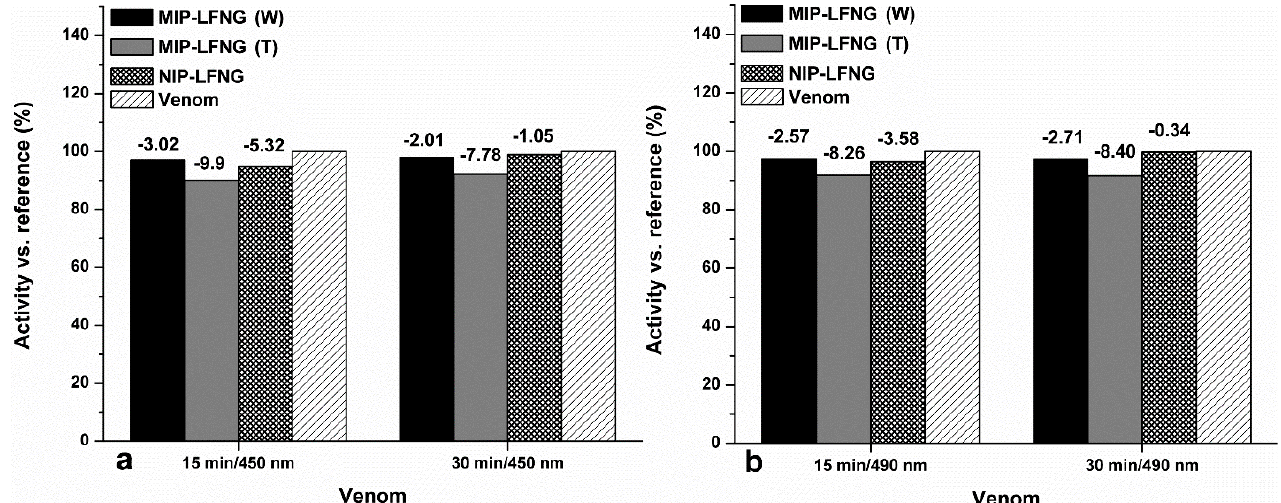
Figure 5. The drop in PLA2 activity after LFNG exposure to venom at 15 and 30 min and evaluated at ( a ) 450 nm and ( b ) 490 nm.